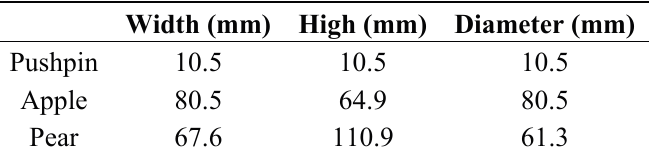
Table 1. Vision target sizes.